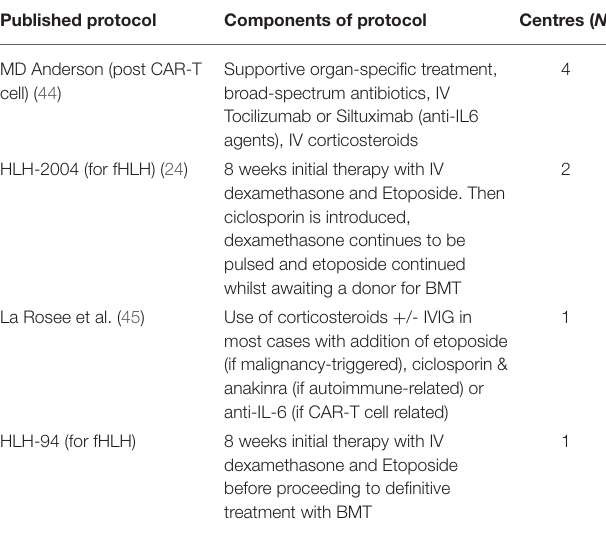
TABLE 2 | Use of published protocols in the management of sHLH/MAS post-HSCT or CAR-T cell therapy. Published